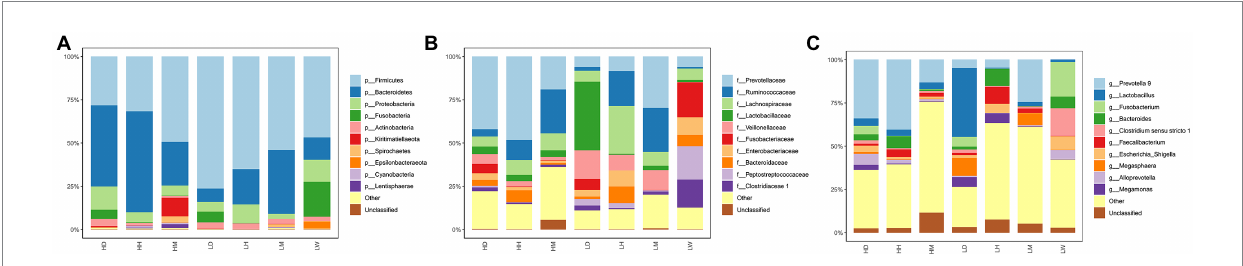
FIGURE 5 Gut microbiota taxonomic composition. Composition of gut microbiota among different groups at (A) phylum level, (B) family level and (C) genus level. The same letter indicates the difference is not significant ( p > 0.05). HH stands for high altitude humans, HD stands for high altitude dogs, HM stands for high altitude wild macaques, LH stands for low altitude humans, LD stands for low altitude dogs, LM stands for low altitude wild macaques, LW stands for low